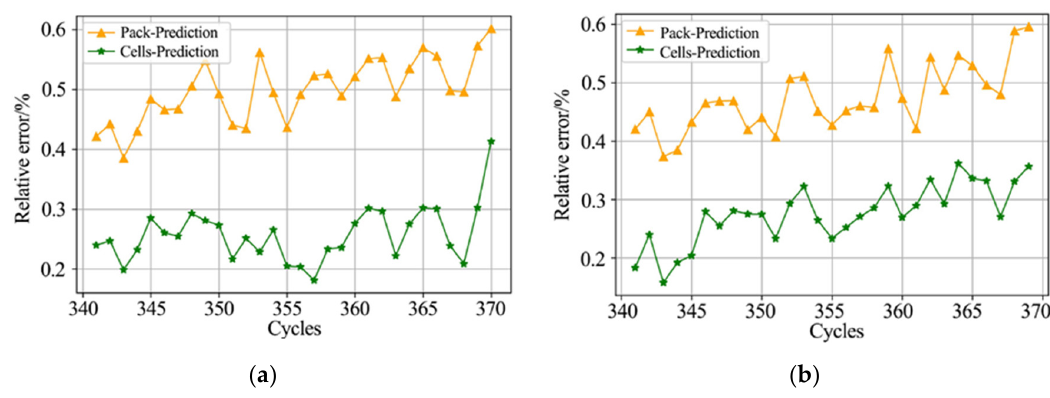
Figure 14. Relative errors of the prediction results: ( a ) series; ( b ) parallel.